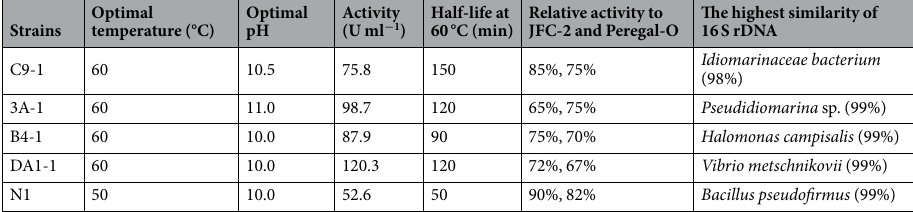
Table 1. Characterization of crude proteases from the screened strains.